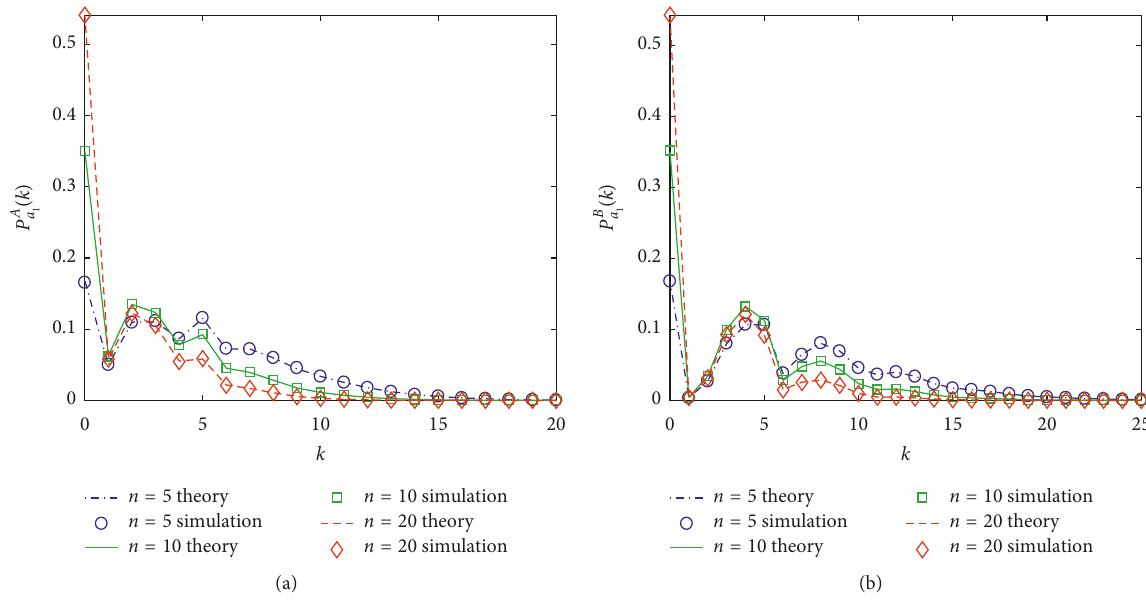
Figure 2: The degree distribution of the nodes with activity a in the instantaneous network G t . Node types in (a) and (b) are, respectively, A 1 and B . The dash-dotted line (circle), solid line (square), and dotted line (diamond) represent the theoretical (simulation) results for n � 5, n � 10, and n � 20, respectively. For the three candidates of n , the values of σ n are 0.0572, 0.1736, and 0.5779, respectively. Other parameters � 0 . 9 , and λ � 0 . 1. The simulation results are averaged over 1,000 are set to be N � 10 , 000 , p � 0 . 3 ,m � 5 , λ 1 2